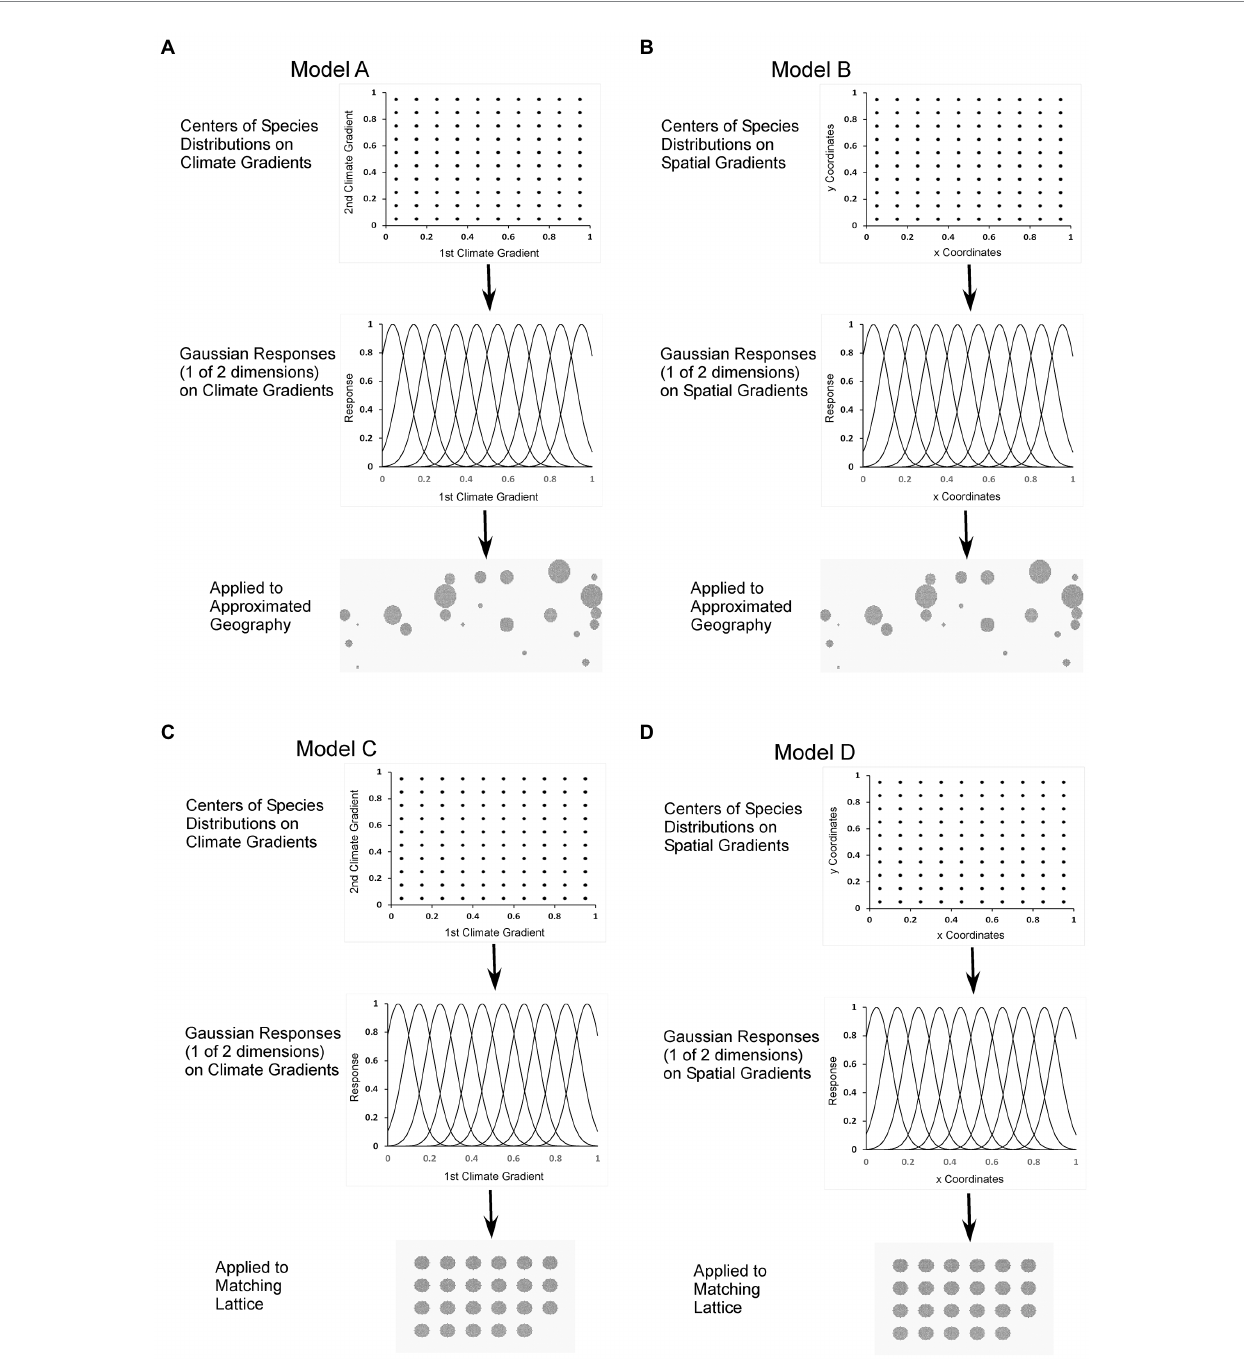
function, chosen here as 0.001, which produced distributions of regional species richness spanning nearly the full possible range across all simulations. Thus, 100 such equations define 100 virtual species with the potential to fill all niches and occupy all locations. The shape of the bells and their overlap for a single row or column are illustrated in Figure 1, middle panels.